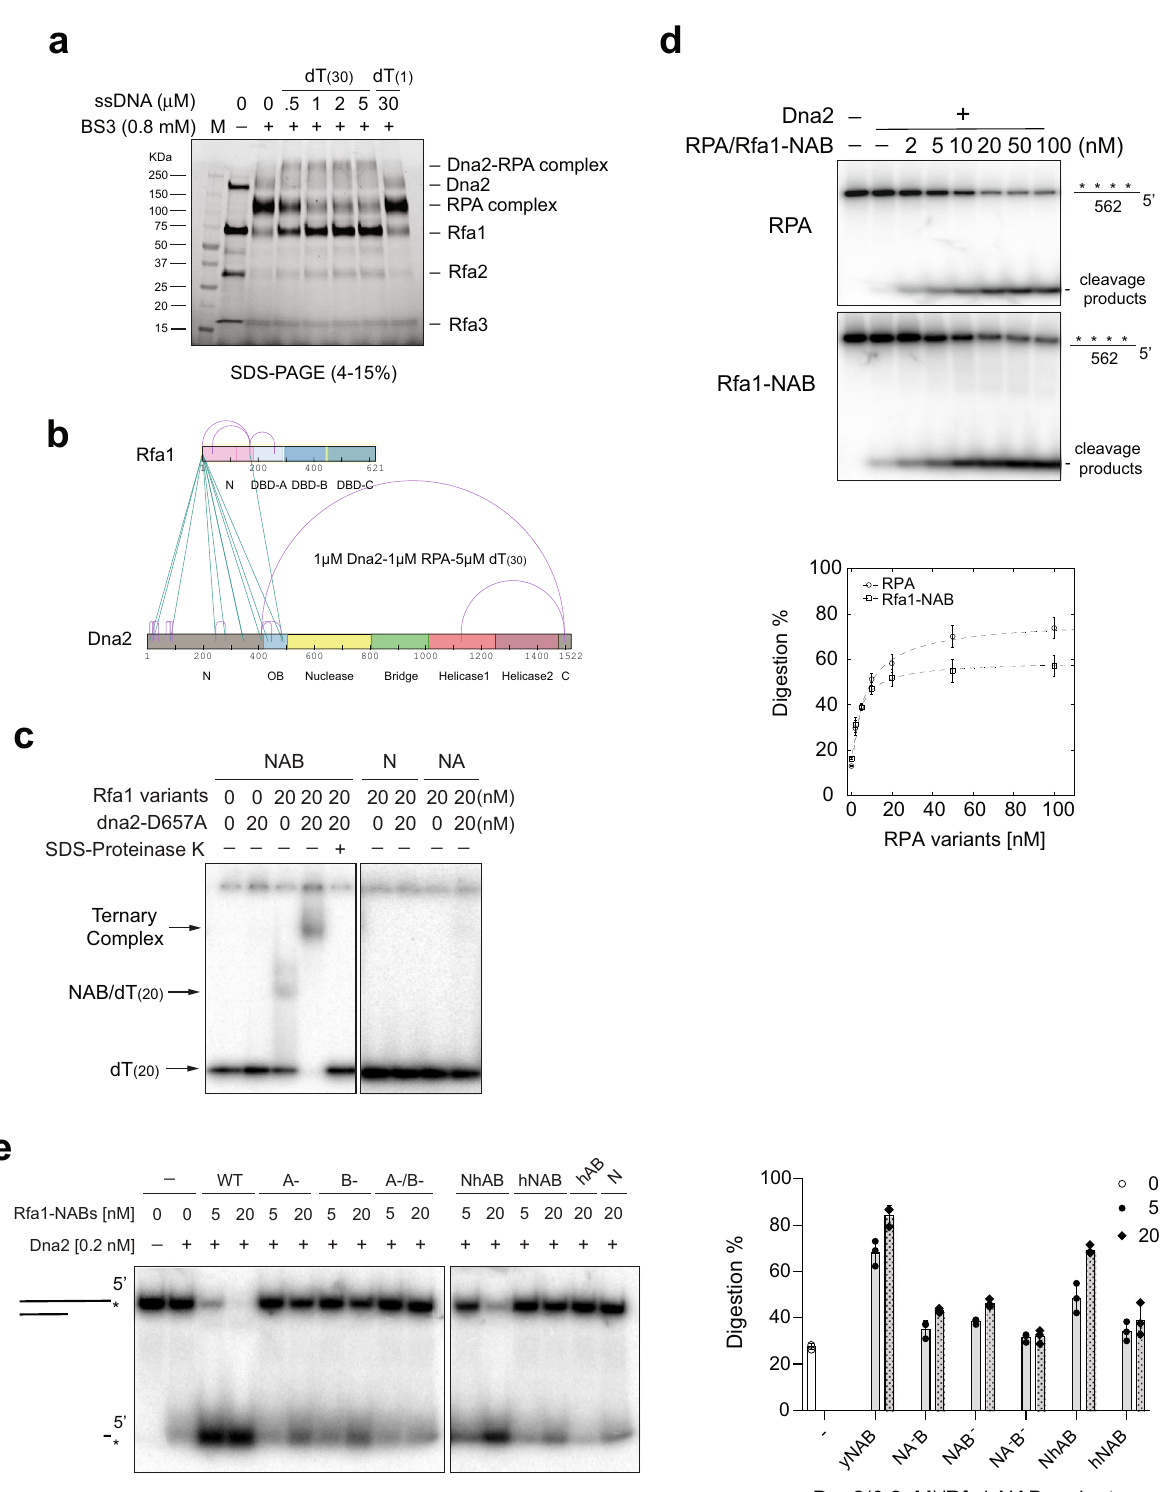
six of the rfa1 – NAB mutants, F15A, Y29A, Y55A, Y96A, Y123A/ F124A, and Y193A, were partially defective in stimulating Dna2 ’ s initial cleavage of a 5 ′ -overhanging DNA (Fig. 5a). Among those six mutants, rfa1 – NAB – Y193A, in particular, is defective not only in supporting the initial 5 ′ -cleavage by Dna2 but also in sup- porting Dna2 ’ s processive cleavage of the same 5 ′ -overhanging DNA (Fig. 5b, c and Supplementary Fig. 5b). In DNA